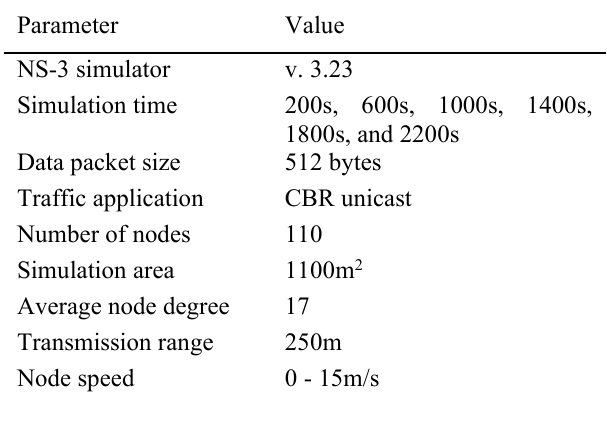
Table 1. Simulation